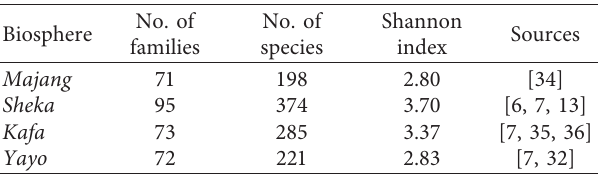
Figure 3: Size of the zone in all biosphere reserves in Southwestern Ethiopia. Source: [29, 33]. Table 1: Plant diversity in the biosphere reserves of Southwest